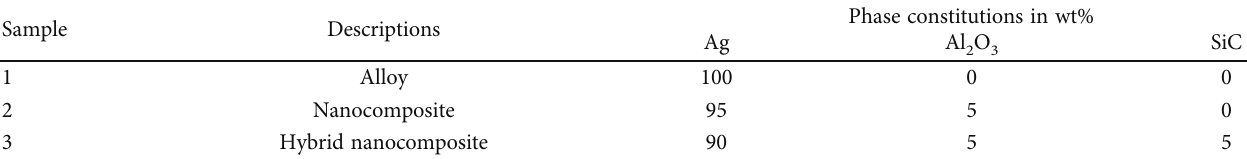
Table 3: Phase constitutions of silver matrix